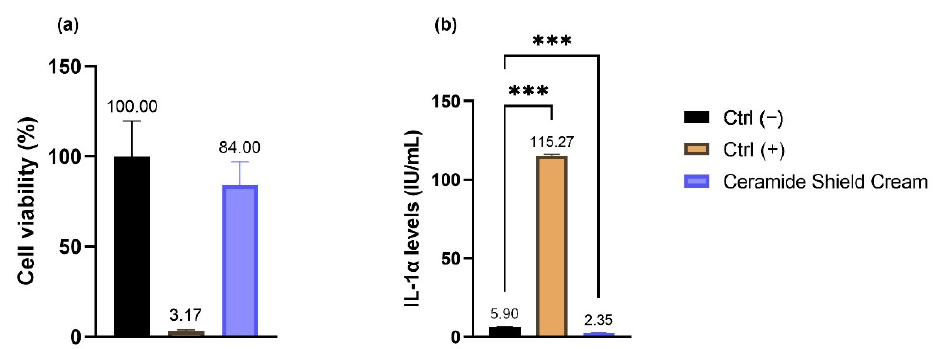
Figure 5. ( a ) Cell viability expressed as a percentage (%) of RHE treated with Ceramide Shield Cream. Ctrl ( − ): RHE treated with DPBS; Ctrl (+): RHE treated with SDS as the irritating stimulus. ( b ) IL-1 α amount (IU/mL) in the medium after treatment with Ceramide Shield Cream; Ctrl ( − ): cells treated with DPBS; Ctrl (+): RHE treated with SDS. Values of *** p ≤ 0.001 were considered statistically significant compared with Ctrl ( − ) by one-way ANOVA statistical analysis followed by Fisher’s LSD